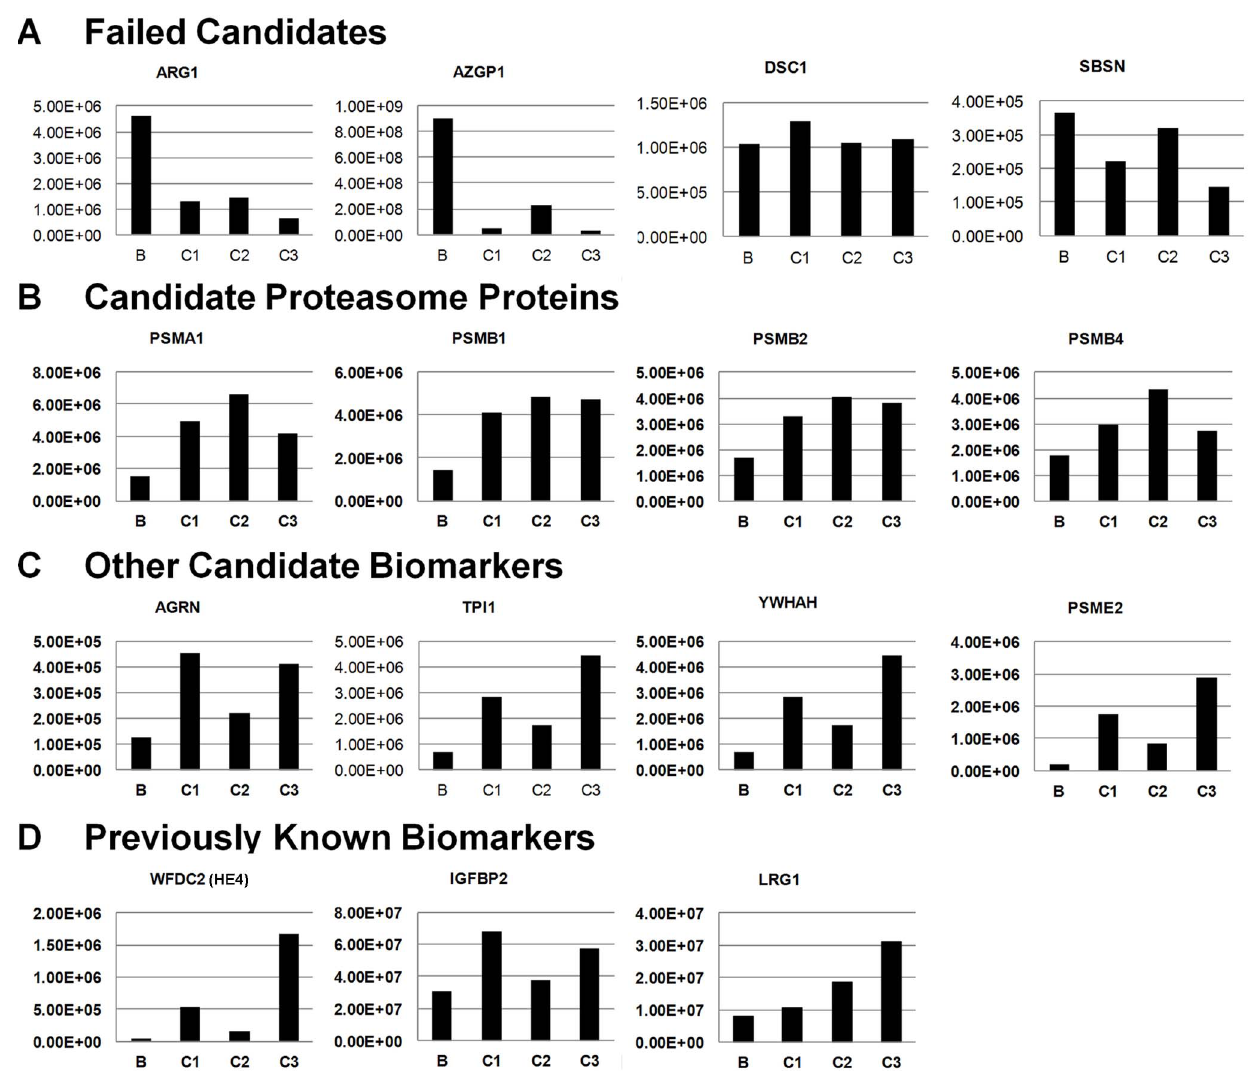
Figure 4. Quantitative comparisons of candidate biomarkers using label-free discovery mode LC-MS/MS analysis of patient serum pools. Summed protein intensities from a Rosetta Elucidator label-free analysis are shown for benign (B, n=9) and three different late-stage ovarian cancer pools (C1, n=9; C2, n=9; C3, n=5). (A) Representative proteins that failed this screen because intensities were lower or showed no difference in cancer pools compared with benign disease. (B) Four different isoforms of the proteasome complex selected for further validation because they showed elevated levels in all cancer pools compared with benign sera. (C) Additional representative proteins selected for further validation because they showed elevated levels in all cancer pools compared with benign sera. (D) Three biomarkers previously reported by others and re-discovered in the current study (see Table 1 ).